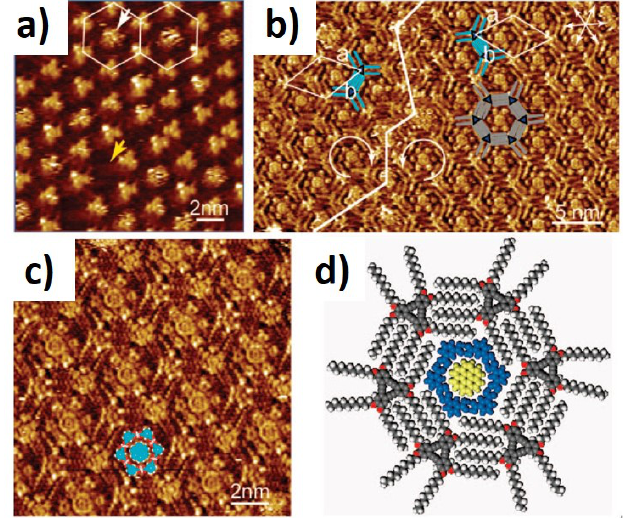
Figure 6. STM images of nanoporous monolayers developed using DBA - OC 10 building blocks at the HOPG/1-octanoic acid interface. The DBA host network can be visualized with ( a ) and without ( b ) a guest molecule (an heterocluster of ISA and COR); ( c ) high-resolution STM image of (b); ( d ) schematic representation of one host-guest system. (Reprinted with permission from reference [55]. Copyright 2008 The American Chemical